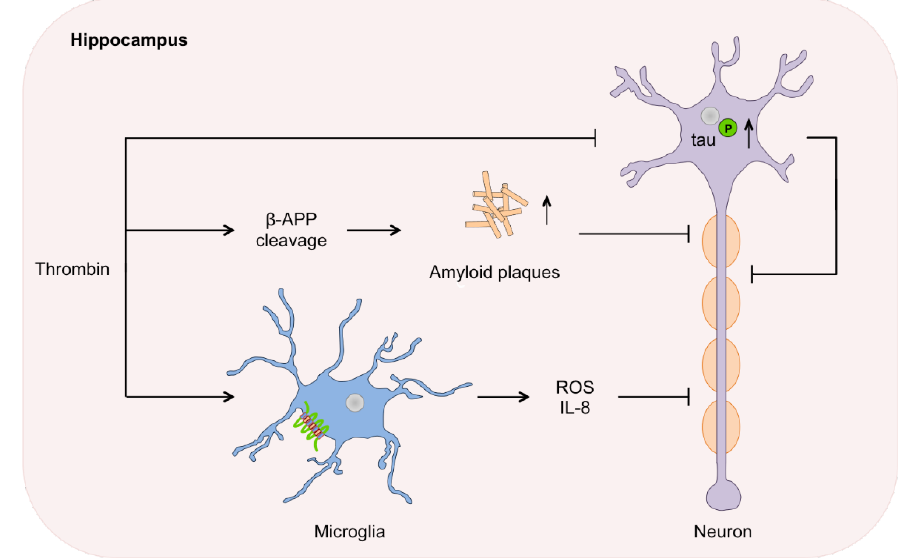
Figure 2. Alzheimer’s disease. In brains of patients with AD, thrombin is present in senile plaques, amyloid deposits, microvessels and neurofibrillary tangles. Thrombin-dependent activation of PAR1/4 results in hyperphosphorylation and aggregation of tau protein leading to apoptosis of predominantly hippocampal neurons. Furthermore, thrombin induces the cleavage of amyloid- β precursor protein ( β -APP) leading to the amyloid β (A β) accumulation (amyloid plaques), which have neurotoxic capacity. Additionally, microglia activation by thrombin leads to the generation of reactive oxygen species (ROS) and proinflammatory proteins e.g.,